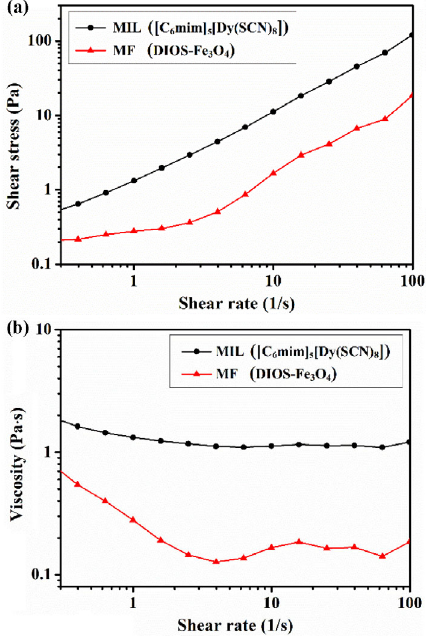
Fig. 4 Variations in (a) shear stress and (b) viscosity of the MIL and MF with shear rate at 25 °